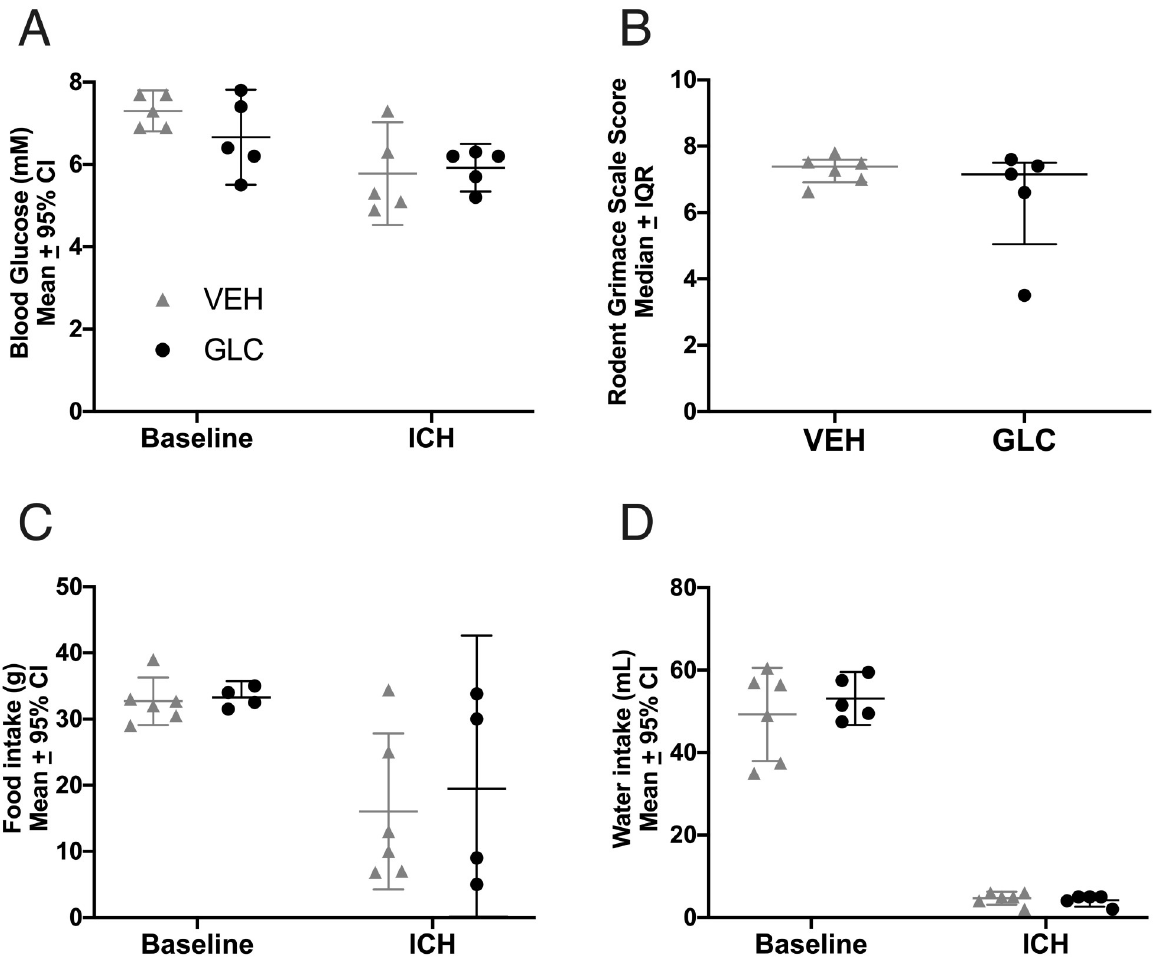
Fig 3. Experiment 1 safety measures. Blood glucose (A, p = 0.0139), RGS (B, p = 0.0139), food intake (C, p = 0.0079), and water intake (D, p < 0.0001) were all decreased following ICH. (Fig 5A, p = 0.0611). Fe (an estimate of hematoma volume) was significantly higher in the ipsi- lateral striatum (p < 0.0001 vs. contralateral striatum, Cohen’s d groups (Fig 5B, p = 0.9466). Na + (p = 0.0033, Cohen’s d = 2.87) were significantly different between hemispheres but not between groups (Fig 5C and 5D, p � 0.6542).